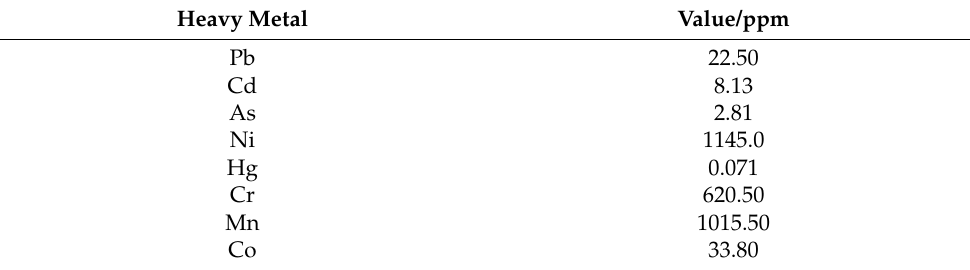
Table 3. Heavy metal content of the fly ash sample.